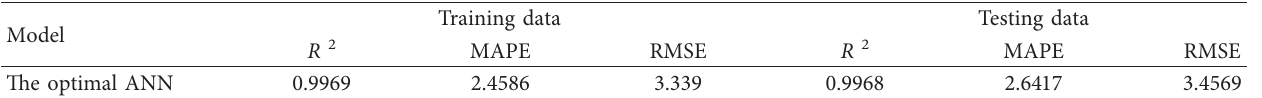
Figure 4: The optimal ANN architecture. Table 9: The optimal ANN model performance